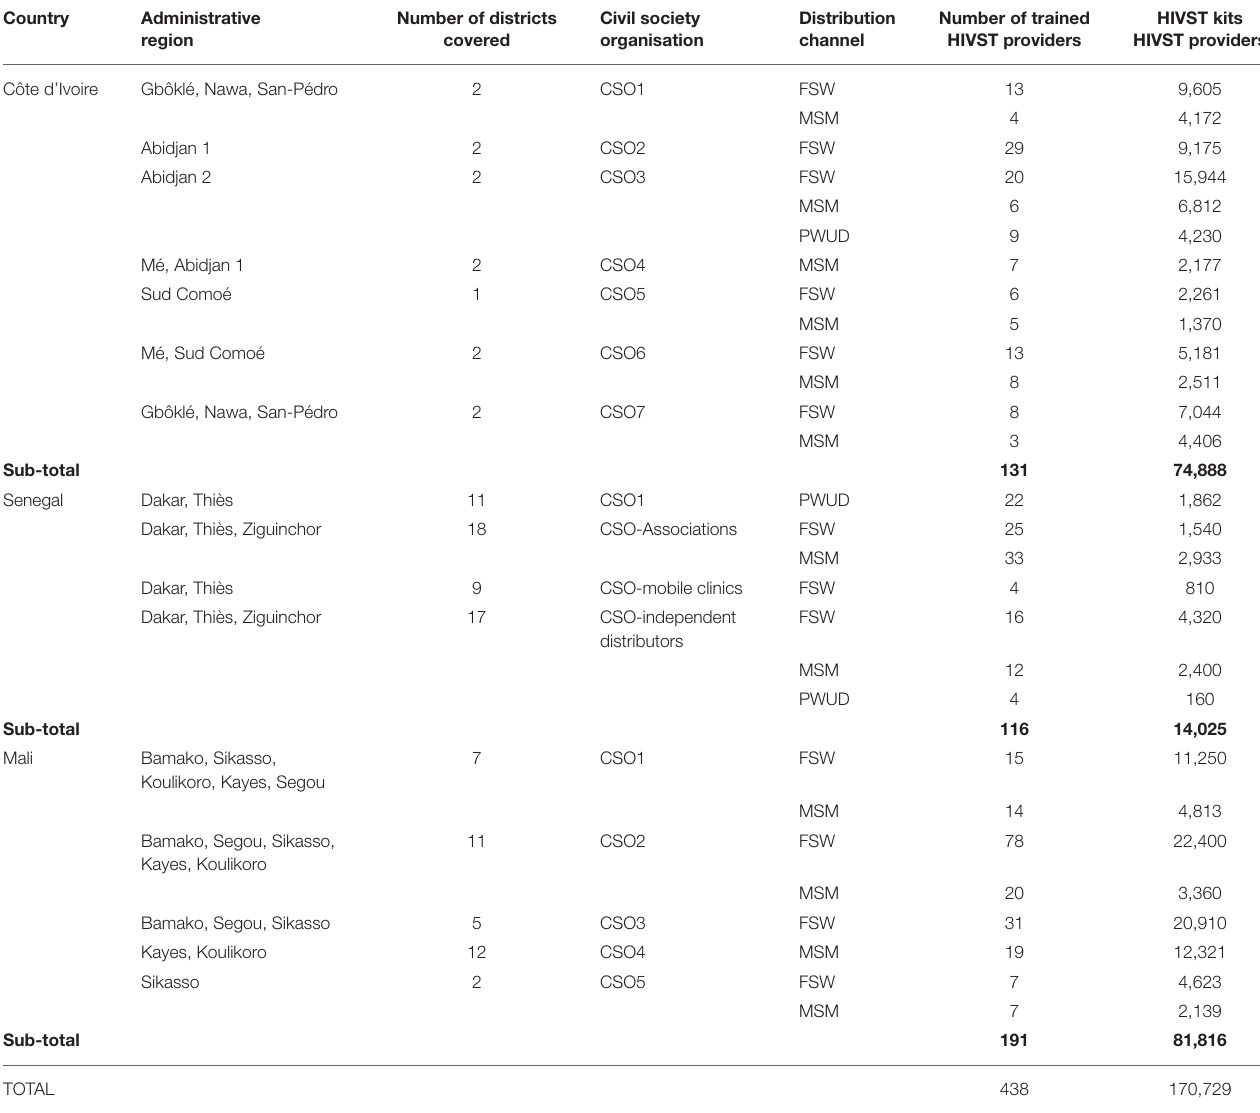
TABLE 1 | Overview of 1the ATLAS project’s implementing partners in Côte d’Ivoire, Senegal, and Mali.